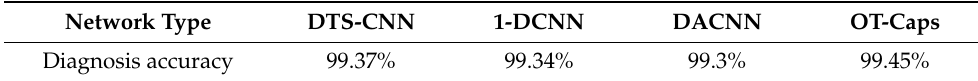
Table 3. Comparison of gearbox fault diagnosis accuracy.